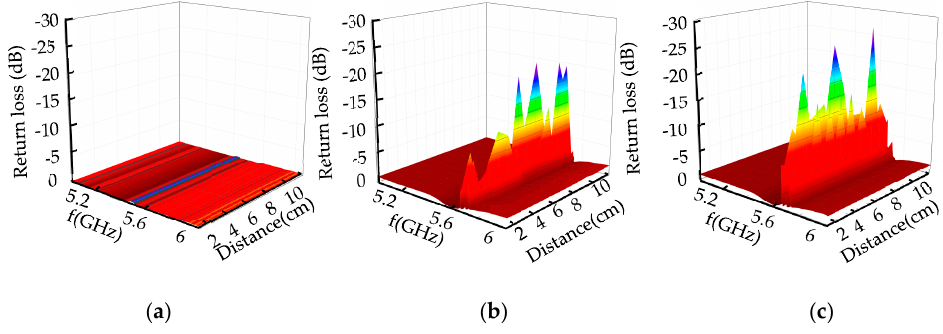
Figure 17. Microwave detection signals of different defects. ( a ) No defect. ( b ) Triangular prism defect. ( c ) Trapezoid defect.